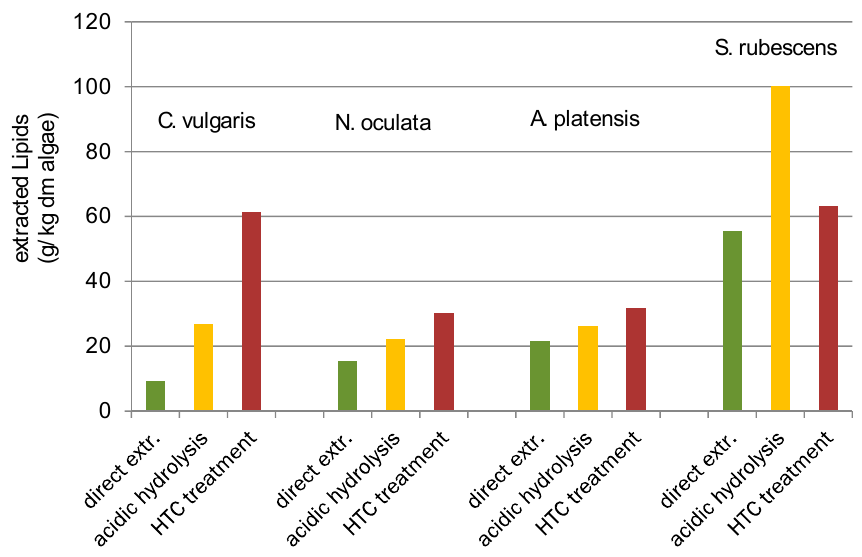
Figure 5. Extraction yields for the different species at different pre-treatments.